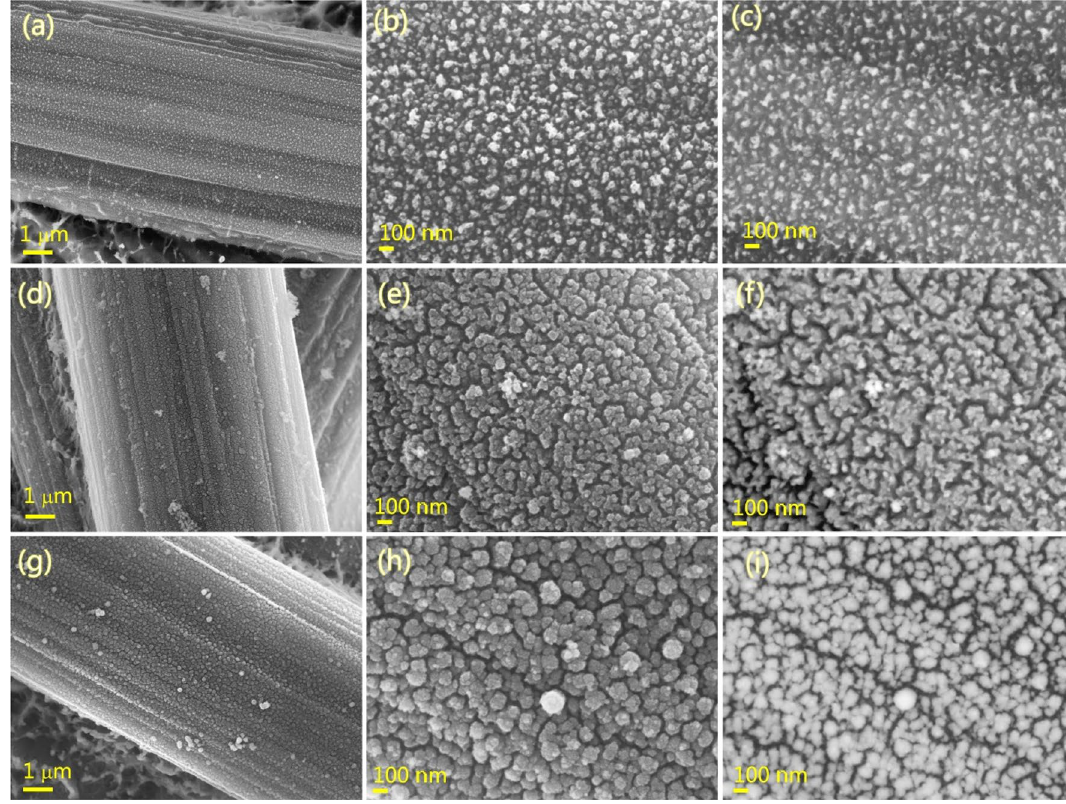
Fig. 4 a Low magnification secondary electron image, b high magnification secondary electron image and c high magnification back-scattered electron image of the 3-Ni/CP. d – f are the corresponding images of the 6-Ni/CP and g – i , of